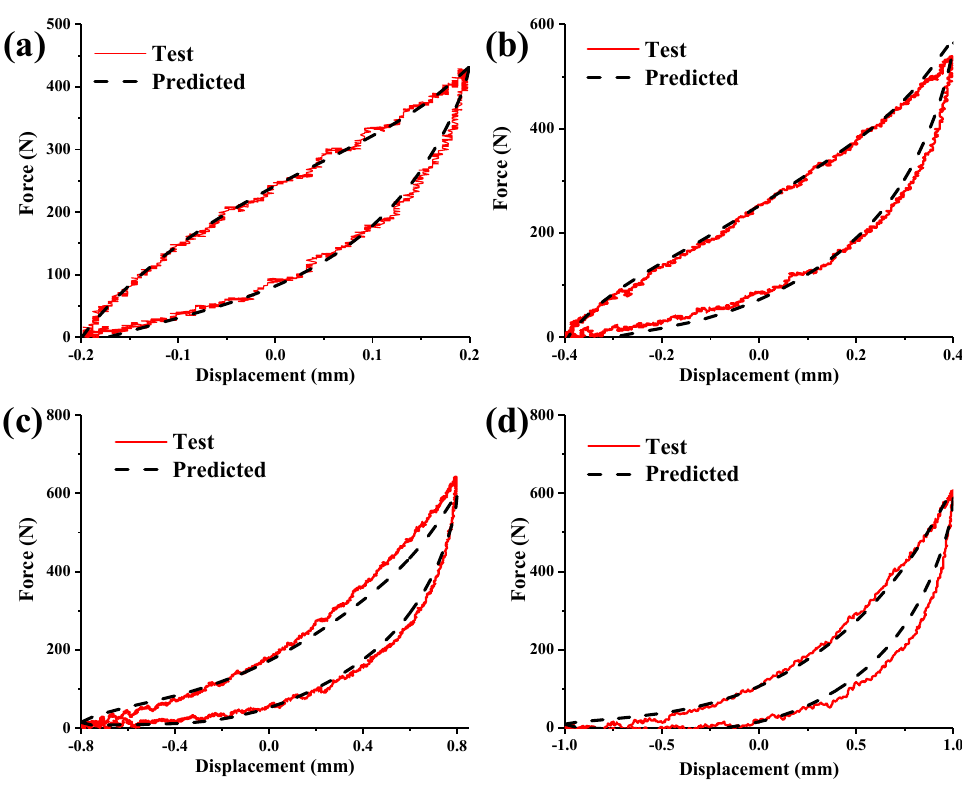
Figure 7. Comparison of the predicted force–displacement curves of pot-shaped metal rubber with the experimental results: ( a ) 0.2 mm, ( b ) 0.4 mm, ( c ) 0.8 mm, and ( d ) 1.0 mm.